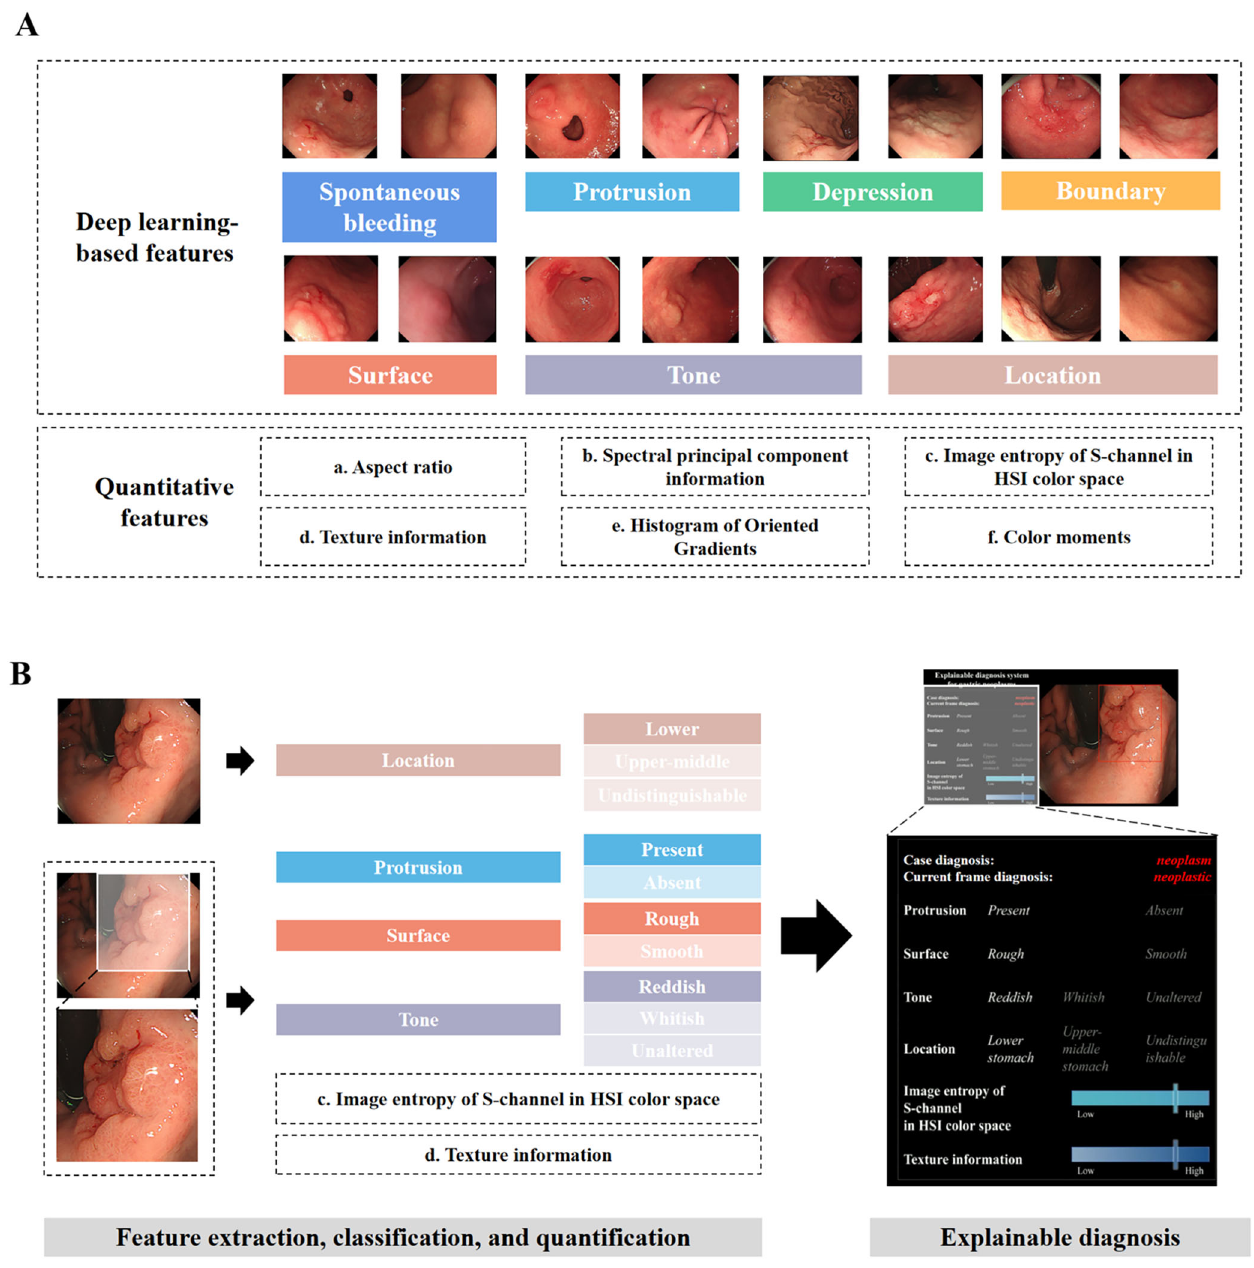
Fig. 1 The performance of machine learning (ML) models and the weights of the included feature indexes. A The performance of the seven ML models on the internal image test set. Random forest (RF) showed the best performance. B Six indexes were determined by the RF model and the corresponding weights. RF random forest, GNB Gaussian Naive Bayes, KNN k-Nearest Neighbor, LR logistic regression, DT decision tree, SVM support vector machine, GBDT gradient boosting decision